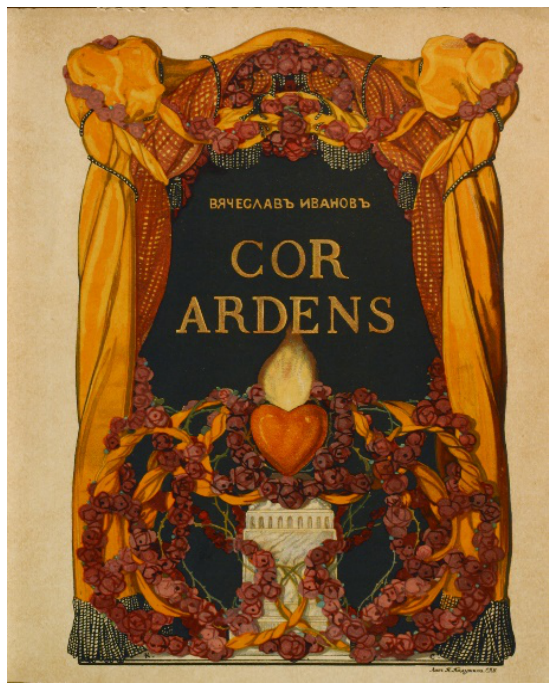
Figure 4. Vyach. Ivanov. Cor Ardens. Part 1. Moscow, 1911. Cover by K.A. Somov.